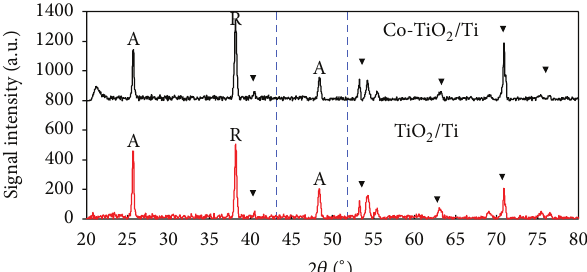
Figure 3: XRD pattern of nanotube TiO 2 /Ti and Co-TiO 2 /Ti obtained through electrosynthesis route; (A) anatase, (R) rutile, and ( 󳶃 ) titanium. The dashed lines indicate the Co 3 O 4 and the fcc-Co position [49].